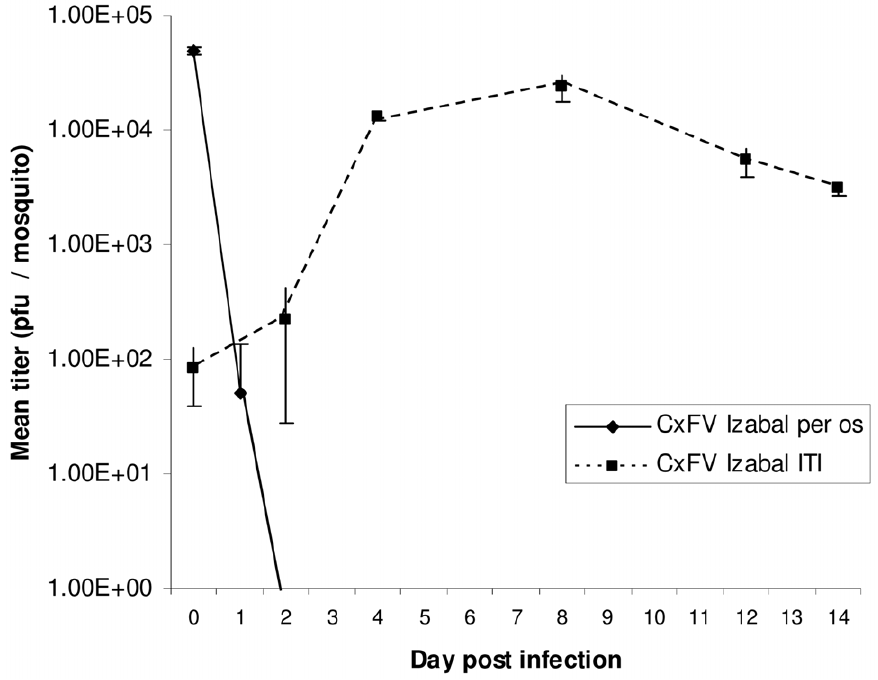
Figure 3. Replication of CxFV Izabal in Cx.quinquefasciatus Sebring mosquitoes. Values at each time point represent the mean 6 standard error of three to five